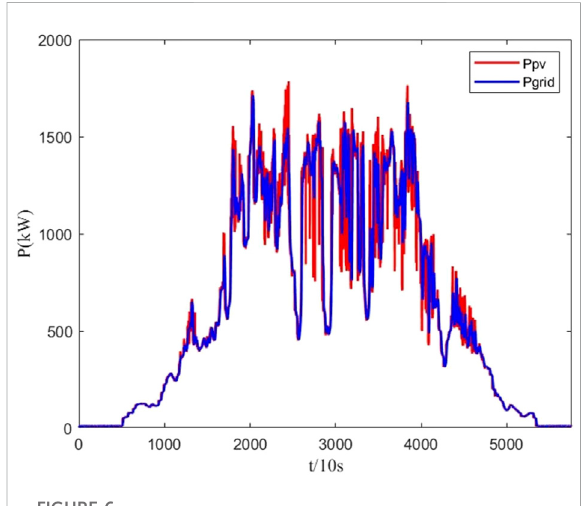
FIGURE 8 Comparison of grid-connected power calculated by RFNN and original